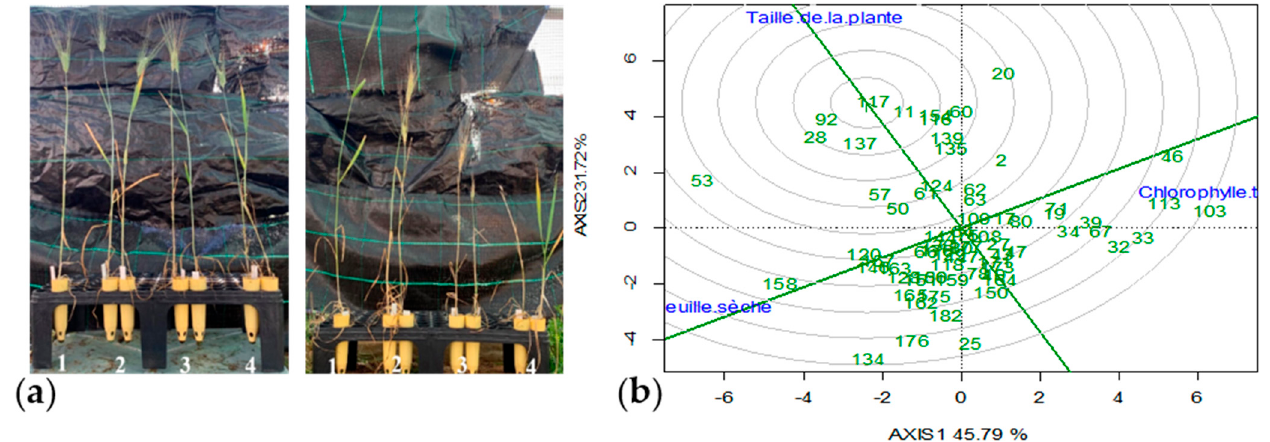
Figure 4. ( a ) Plant height of two genotypes, tolerant (left) and sensitive (right), under 4 treatments. Control (1), 45 mM (2), 90 mM (3), and 135 mM (4). ( b ) Ranking the 70 durum wheat genotypes in terms of chlorophyll content, number of dried leaves, and plant height under a 135 mM salt concentration.